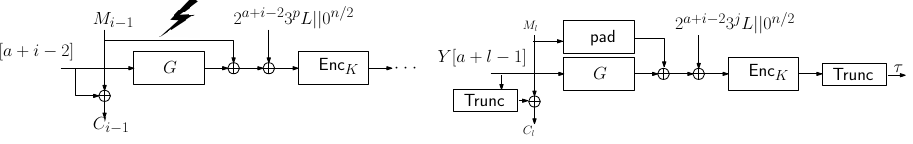
Figure 4: Single-pass mode example: GIFT-COFB.